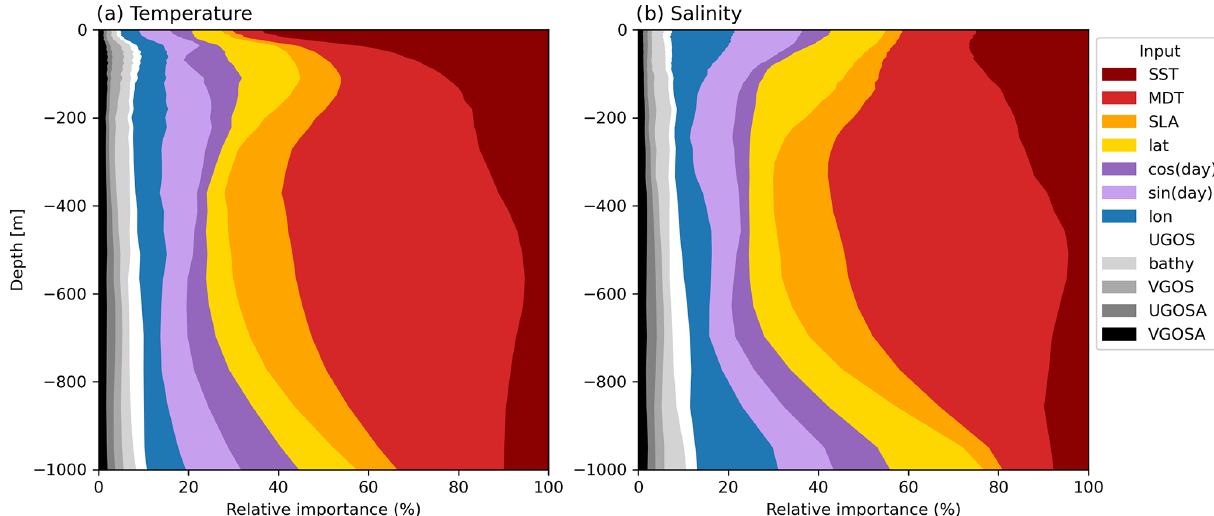
Figure 11. Relative importance of each input for each output, averaged by depth. The areas are sorted by variance to have the input with the largest difference of impact by depth to the right of each